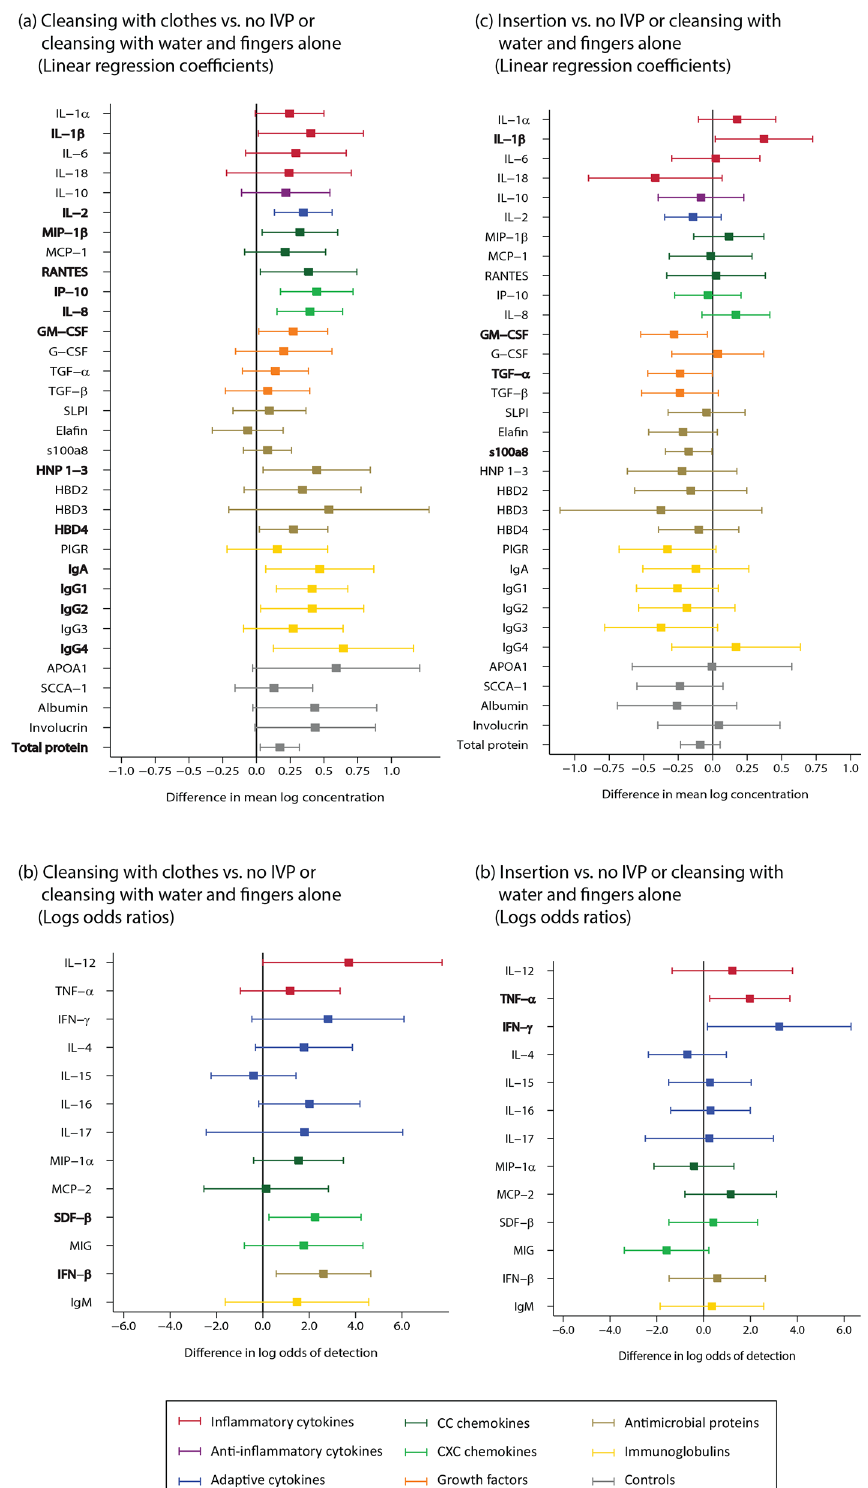
Fig 5. Traditional intravaginal practices (intravaginal cleansing with cloth, n = 155; and intravaginal insertion, n = 145). Bolded analytes represent associations with a p-value (cid:1) 0.05. (A) A comparison of analyte concentration (cid:3) 85% between samples from women who reported intravaginal cleansing with